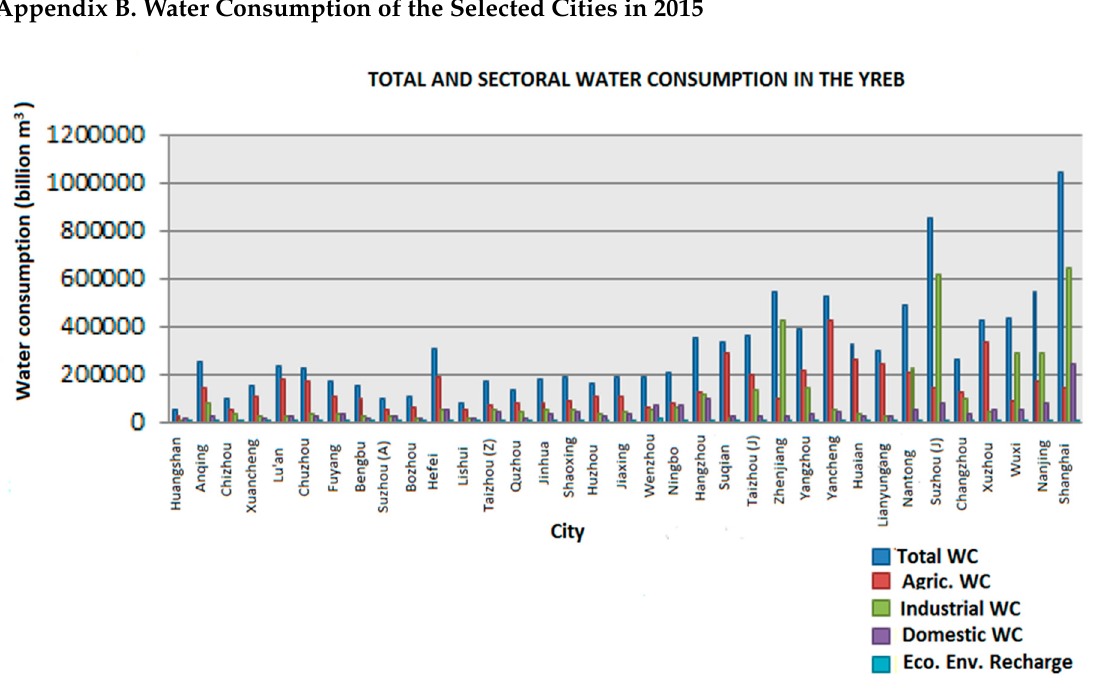
Figure A1. Water Consumption of cities in the YRED. Note, ‘WC’ is water consumption, ‘Eco’. is Ecological and ‘Env’. is Environmental.